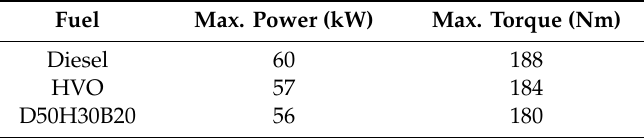
Figure 2. Engine performance parameters for each fuel. Table 7. Maximal values of performance parameters.